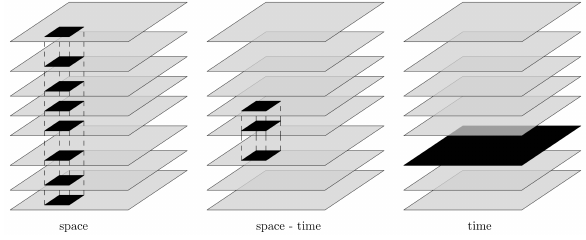
Figure 3: An overview of the important queries Multidimensional selections using SFCs require a modified query algorithm that takes into account the space filling